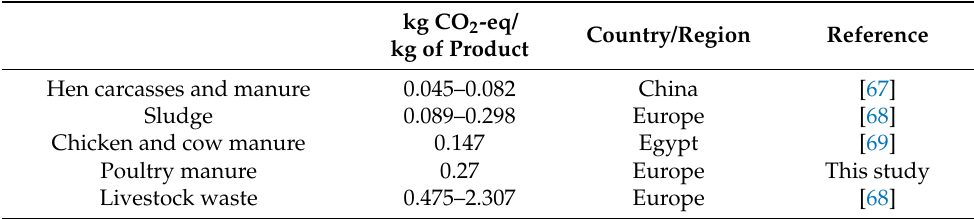
Table 12. Global warming potential (kg CO 2 -eq) values based on a comparison between different composting technologies by scientific